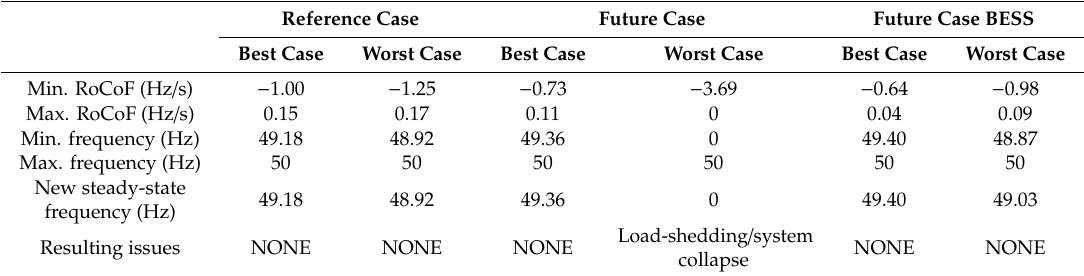
Table 8. Results of generation loss for all scenarios and cases.